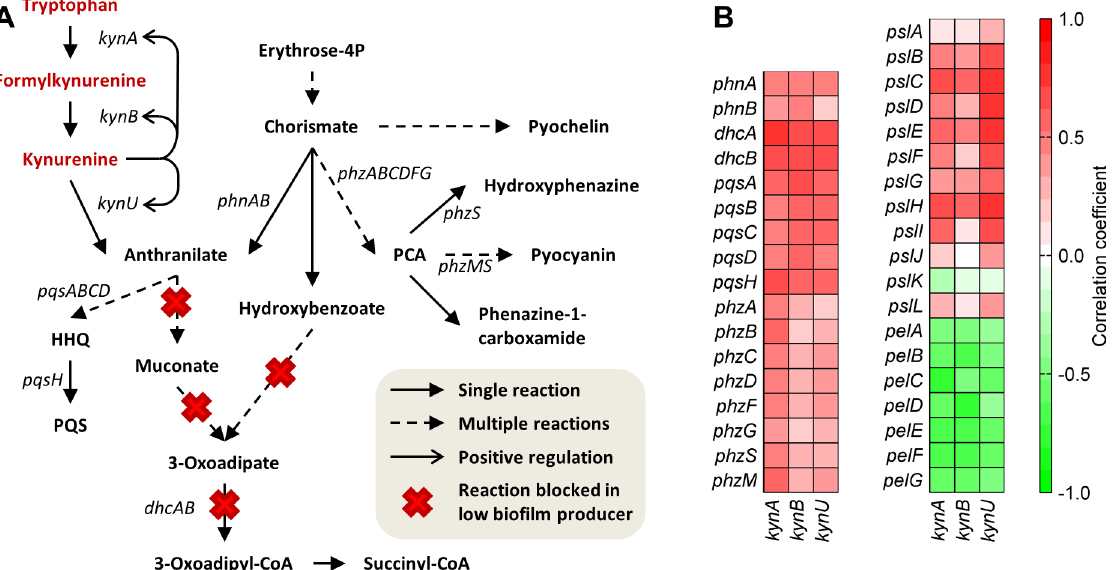
Fig 4. Dysregulation of secondary metabolites related to biofilm formation by inhibition of anthranilate degradation. (A) Sketch of the metabolic pathways involved in anthranilate and chorismate metabolism. Metabolite names written in red were predicted to increase when the reactions marked with a red x, which correspond to the low biofilm producers identified by Costaglioli et al. [11], were inhibited. (B) Correlation of the gene expression intensity of genes associated with anthranilate- and chorismate-derived secondary metabolites, psl and pel genes, with the genes of the kynurenine pathway.